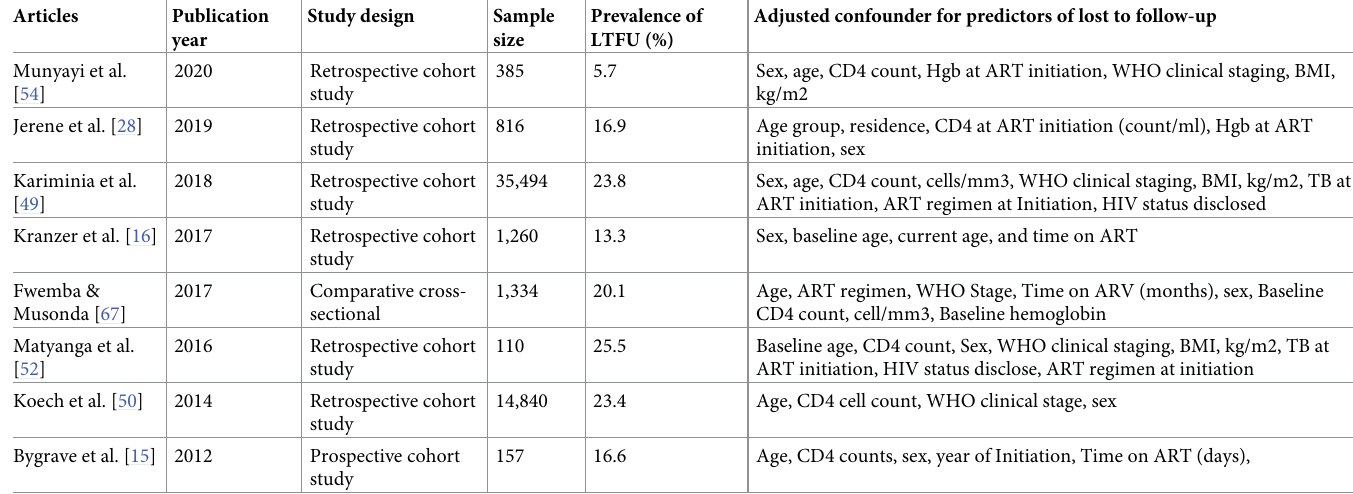
Table 3. Descriptive summary of 8 included studies on the factors associated with LTFU among HIV-positive adolescents between 2005 and 2020.